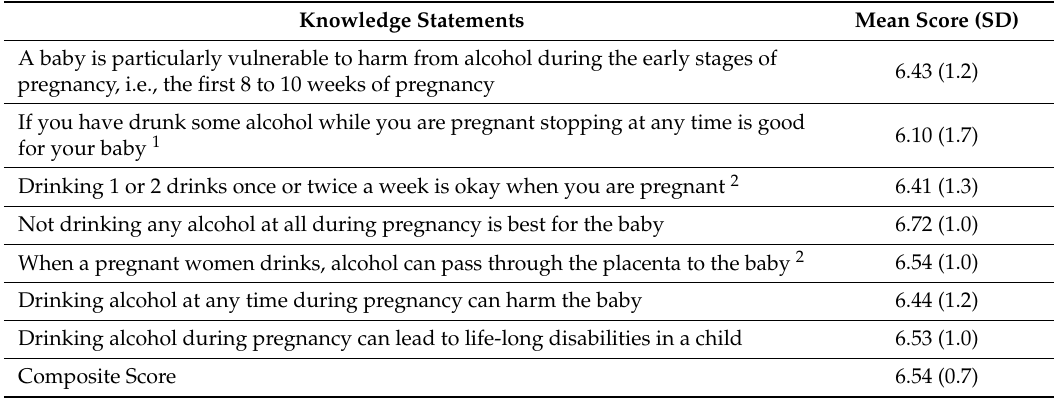
Table 5. Participants’ level of agreement with statements on outcomes of maternal drinking ( n =